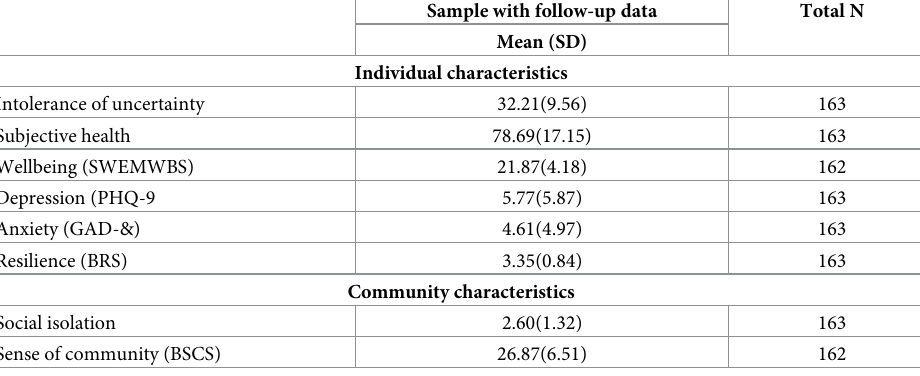
Table 2. Participant characteristics at week 1 (continuous